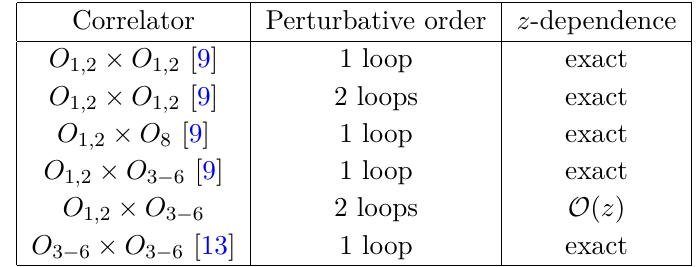
Table 1 . List of ingredients relevant for ∆Γ s . The two-loop result for the O 1 , 2 × O 3 − 6 contribution is